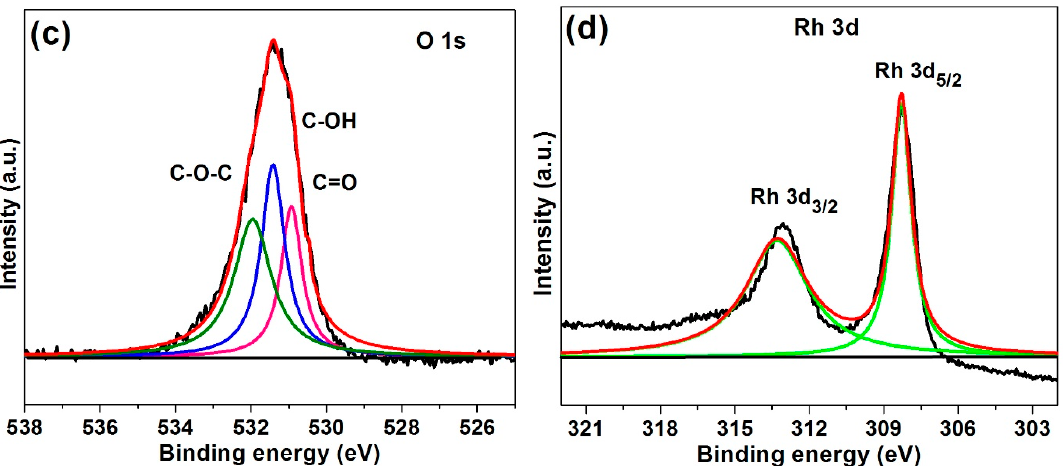
Figure 6. ( a ) X-ray photoemission spectroscope (XPS) survey spectrum of Rh(0)NCs/GNPs, and deconvoluted ( b ) C 1s peak, ( c ) O 1s peak, and ( d ) Rh 3d peaks of Rh(0)NCs/GNPs.